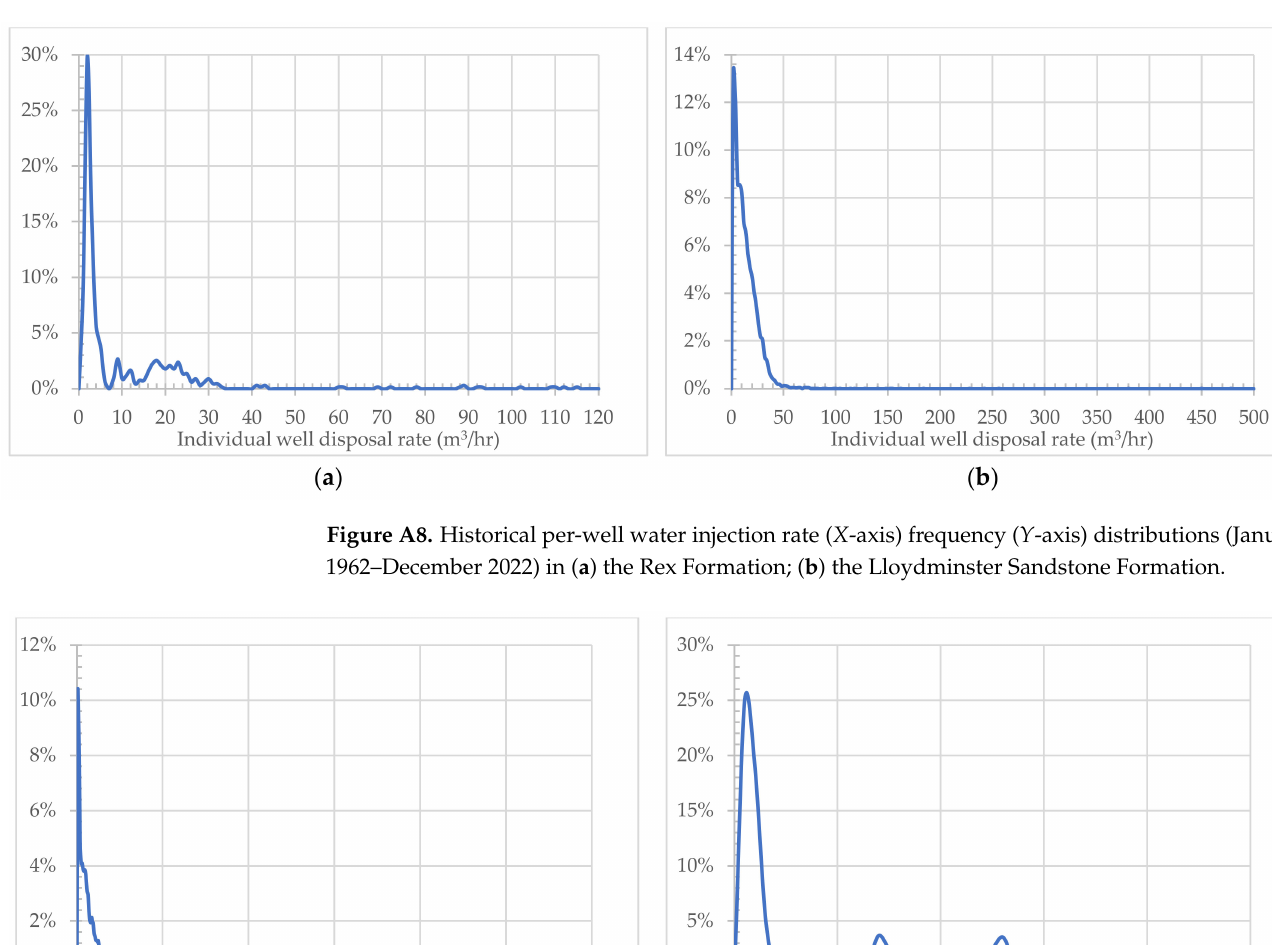
Figure A7. Historical per-well water injection rate ( X -axis) frequency ( Y -axis) distributions (January 1962–December 2022) in ( a ) the Sparky Formation; ( b ) the Falher Formation.